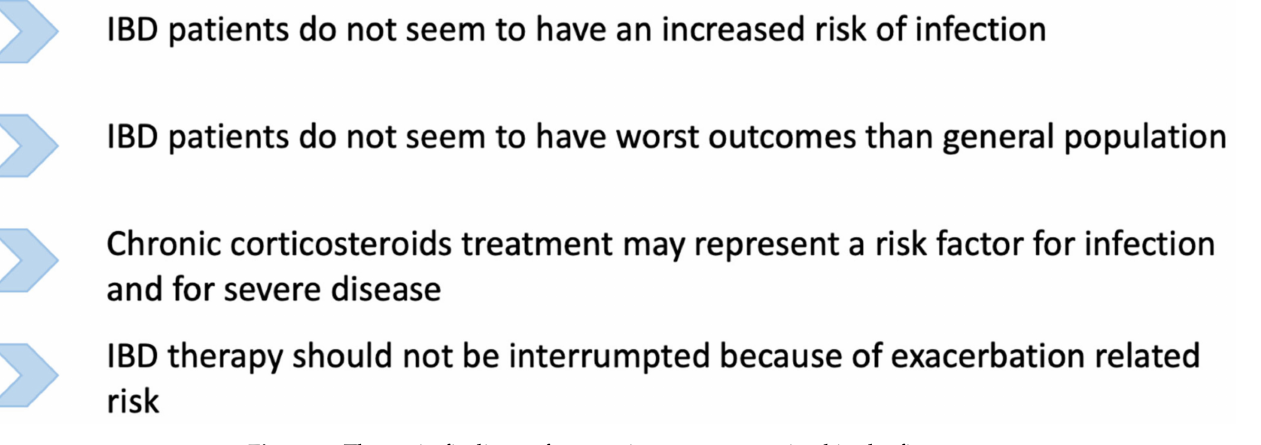
Figure 3. The main findings of our review are summarized in the